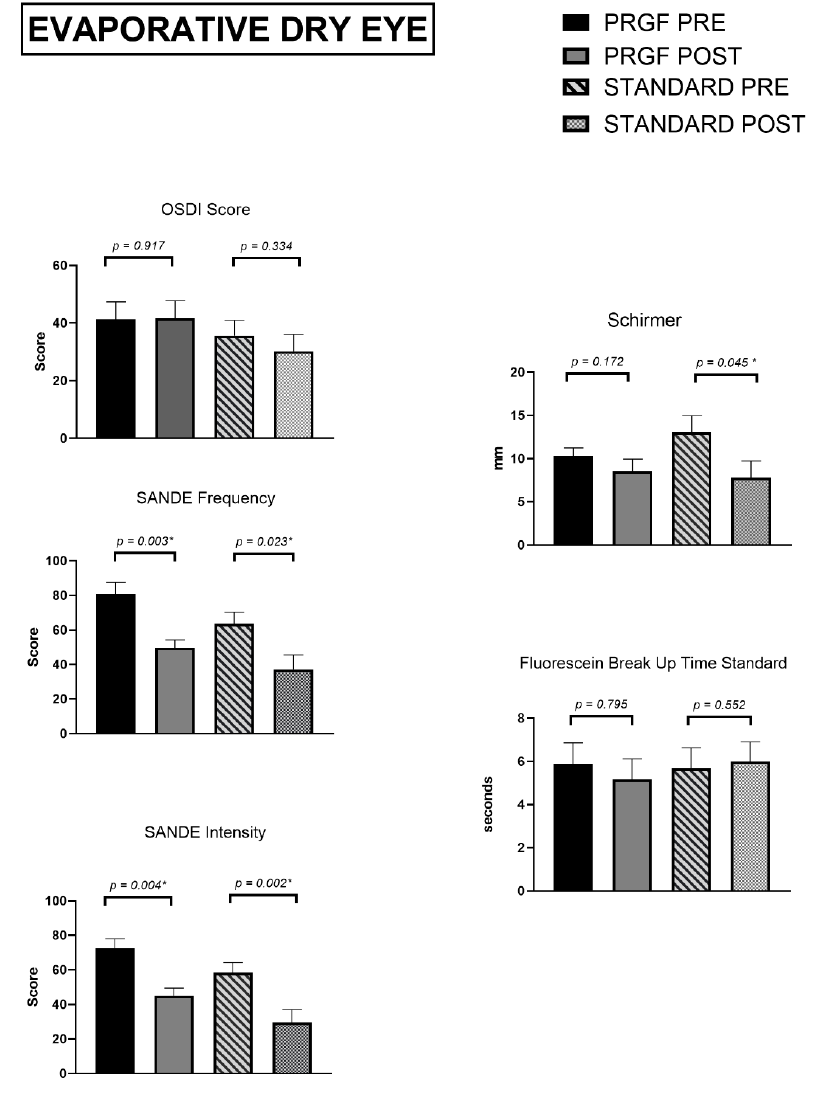
Figure 3. Tear film and psychometric questionnaires for Evaporative Dry Eye Subtype. Asterisks (*) in the graphs indicate statistical differences between groups (p<0.05).